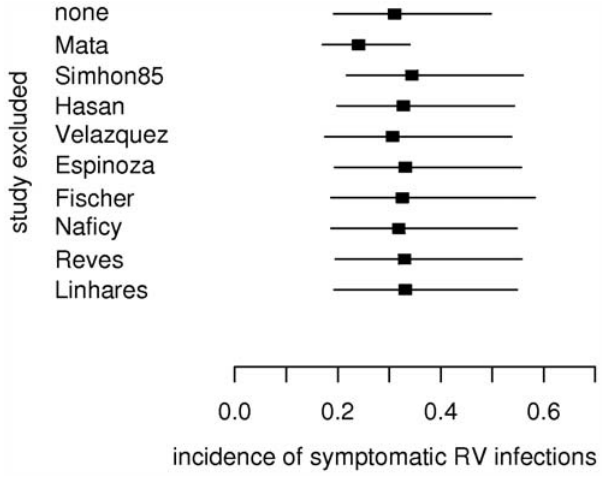
Figure 4. Impact of excluding any particular study from meta- analysis. Impact on the pooled estimate for the incidence of symptomatic RV infections in children below 2 years of age. Squares and horizontal lines represent means and 95% credible intervals of the pooled estimates. Only studies without high risk of bias are considered.